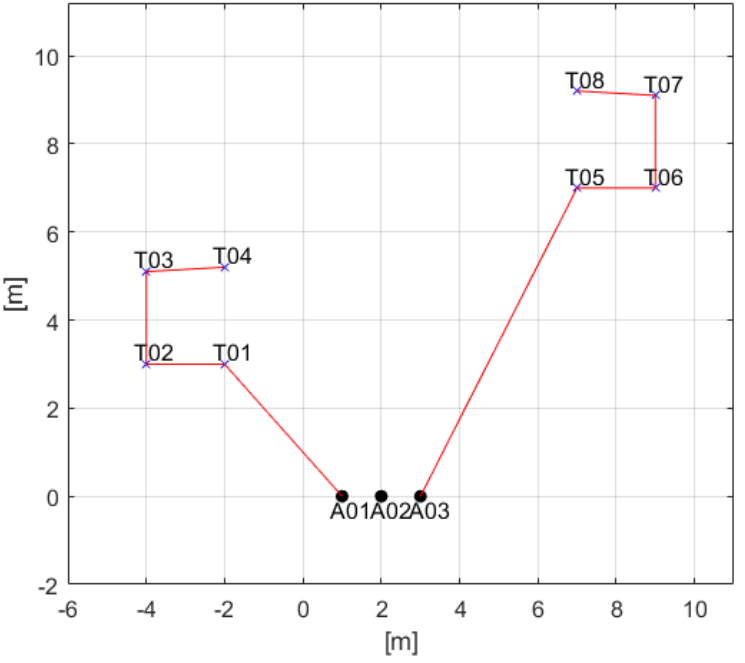
Figure 4. 2 − D result of TACTAR for a simple case applying an accumulated distance cost scheme.